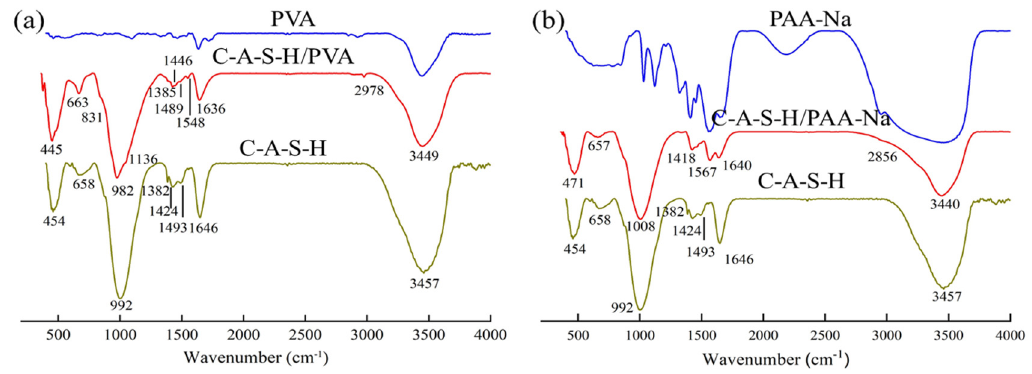
Figure 11. FTIR spectra of ( a ) C ‐ A ‐ S ‐ H/PVA; ( b ) C ‐ A ‐ S ‐ H/PAA ‐ Na. The characteristic vibration bands of PAA ‐ Na and C ‐ A ‐ S ‐ H/PAA ‐ Na are observed at 2856 cm − 1 (C=C) and 1640 cm − 1 (C=O). For the spectrum at 1424 cm − 1 and 1418 cm − 1 , since